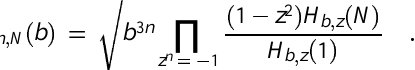
Fig. 4: Perfect matching (cylindrical boundary